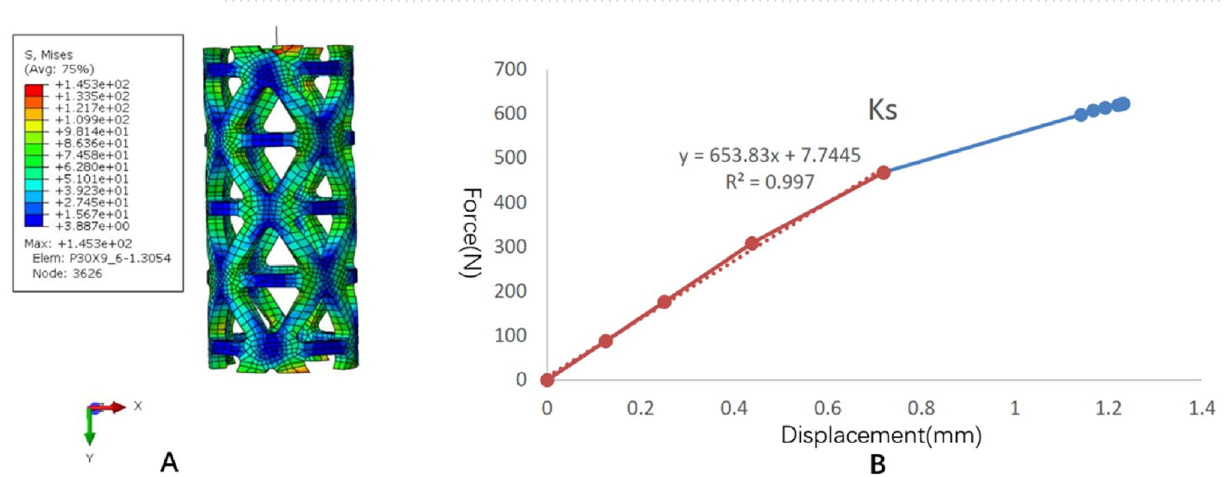
Figure 5. The stress distribution and the force displacement curve of the traditional titanium mesh cage (TTMC)’s Ks. ( A ) The stress distribution diagram; ( B ) the force displacement curve (Abaqus 2016, SIMULIA Co,